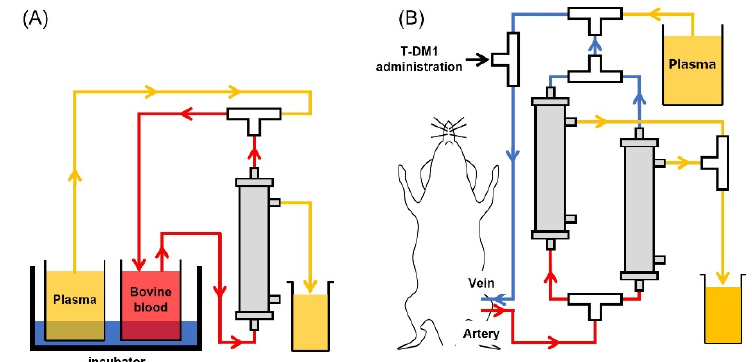
Figure 1. Schematic figure of plasma exchange. (A) In vitro plasma exchange circuits, fluid from the bovine blood pool recovers through the plasma membrane unit. (B) In vivo plasma exchange circuits, femoral vein, and artery were connected to the catheter. Blood was drawn (up to 2 units of plasma exchange) and returned to the femoral vein.